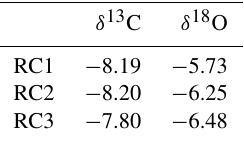
Table 3. δ 13 C and δ 18 O analysis of three recent calcite samples (RC1 to RC3) from the Réseau Renversé.